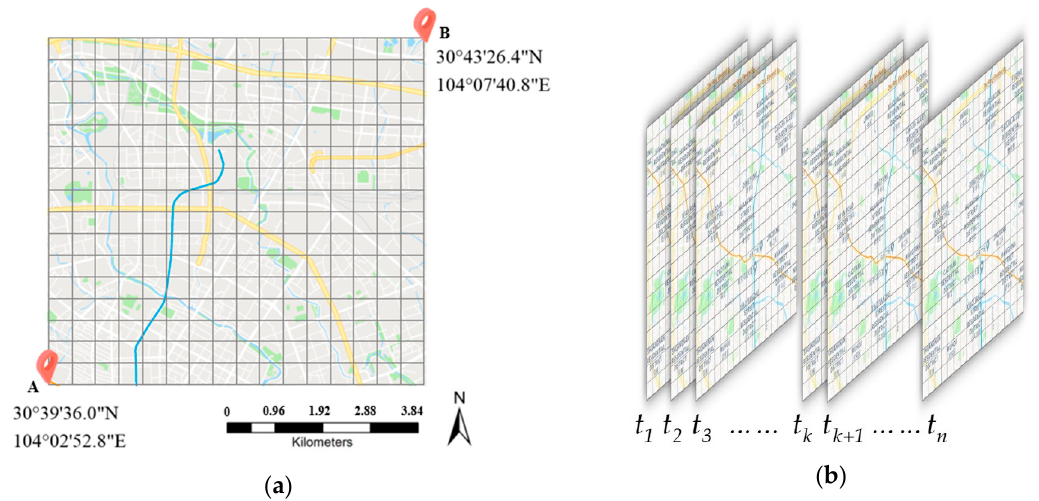
Figure 1. Regions in Chengdu: ( a ) Partition in spatial view; ( b ) partition in temporal view.